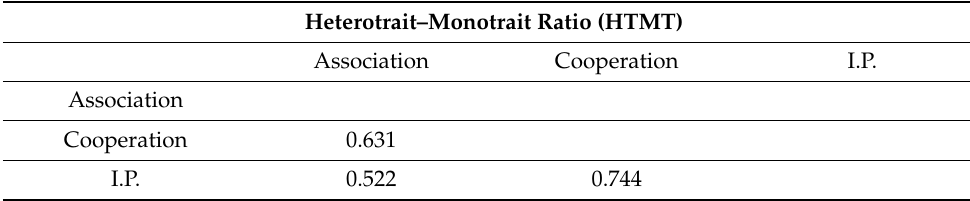
Table 5. Evaluation of discriminant